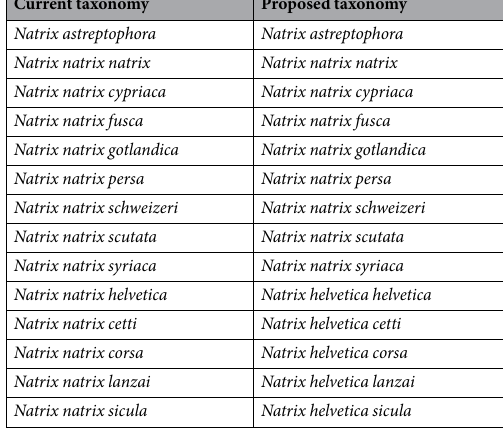
Table 1. Current and proposed taxonomy for grass